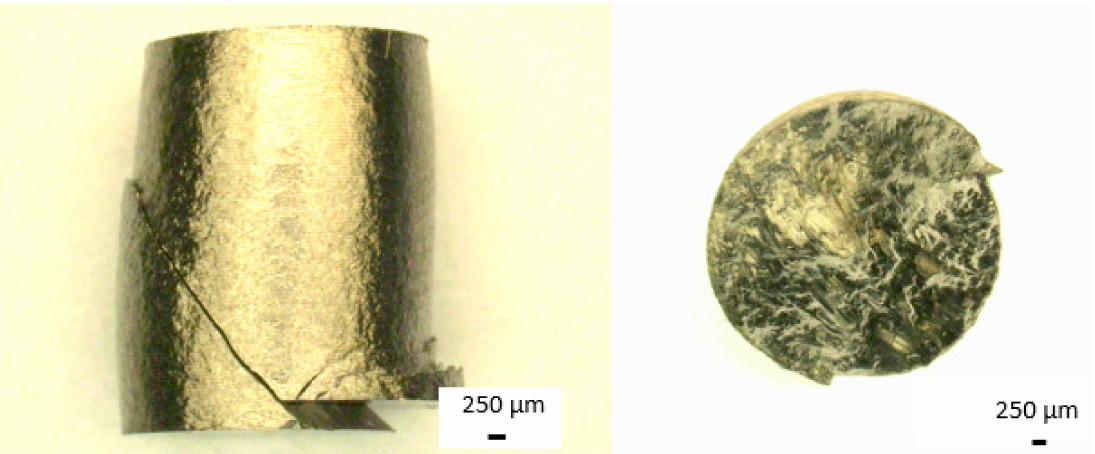
Figure 12. Light microscopy images of Ti-13Nb-13Zr samples after static compression test.